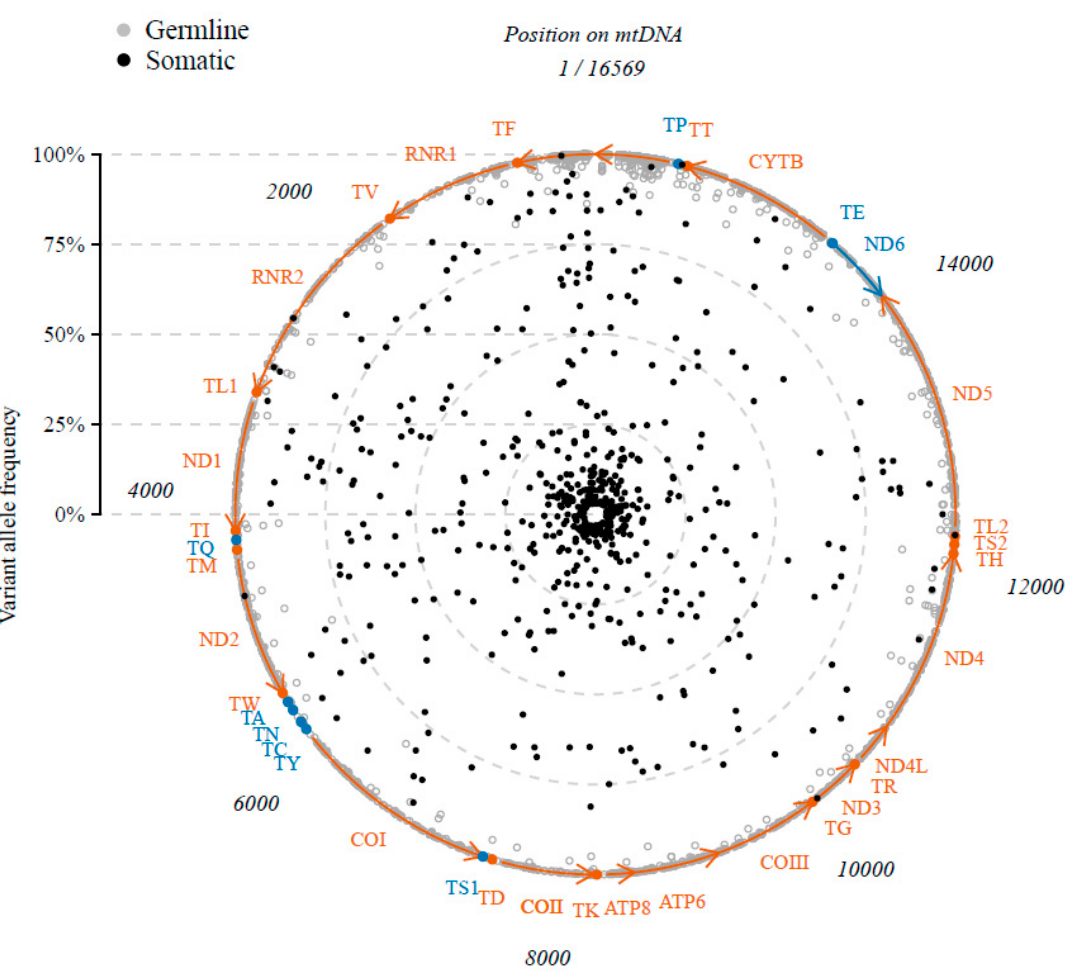
Figure A1. Variants in the mitochondrial DNA of 381 primary breast tumor cases. Position on the mitochondrial genome (circle) and their variant allele frequency (increasing % from inner-to-outer) of all variants identified in the 381 cases. Somatic or germline origin in respectively closed black or open grey circles. Genes and their direction of transcription (arrows) in red (+strand) or blue ( − strand).